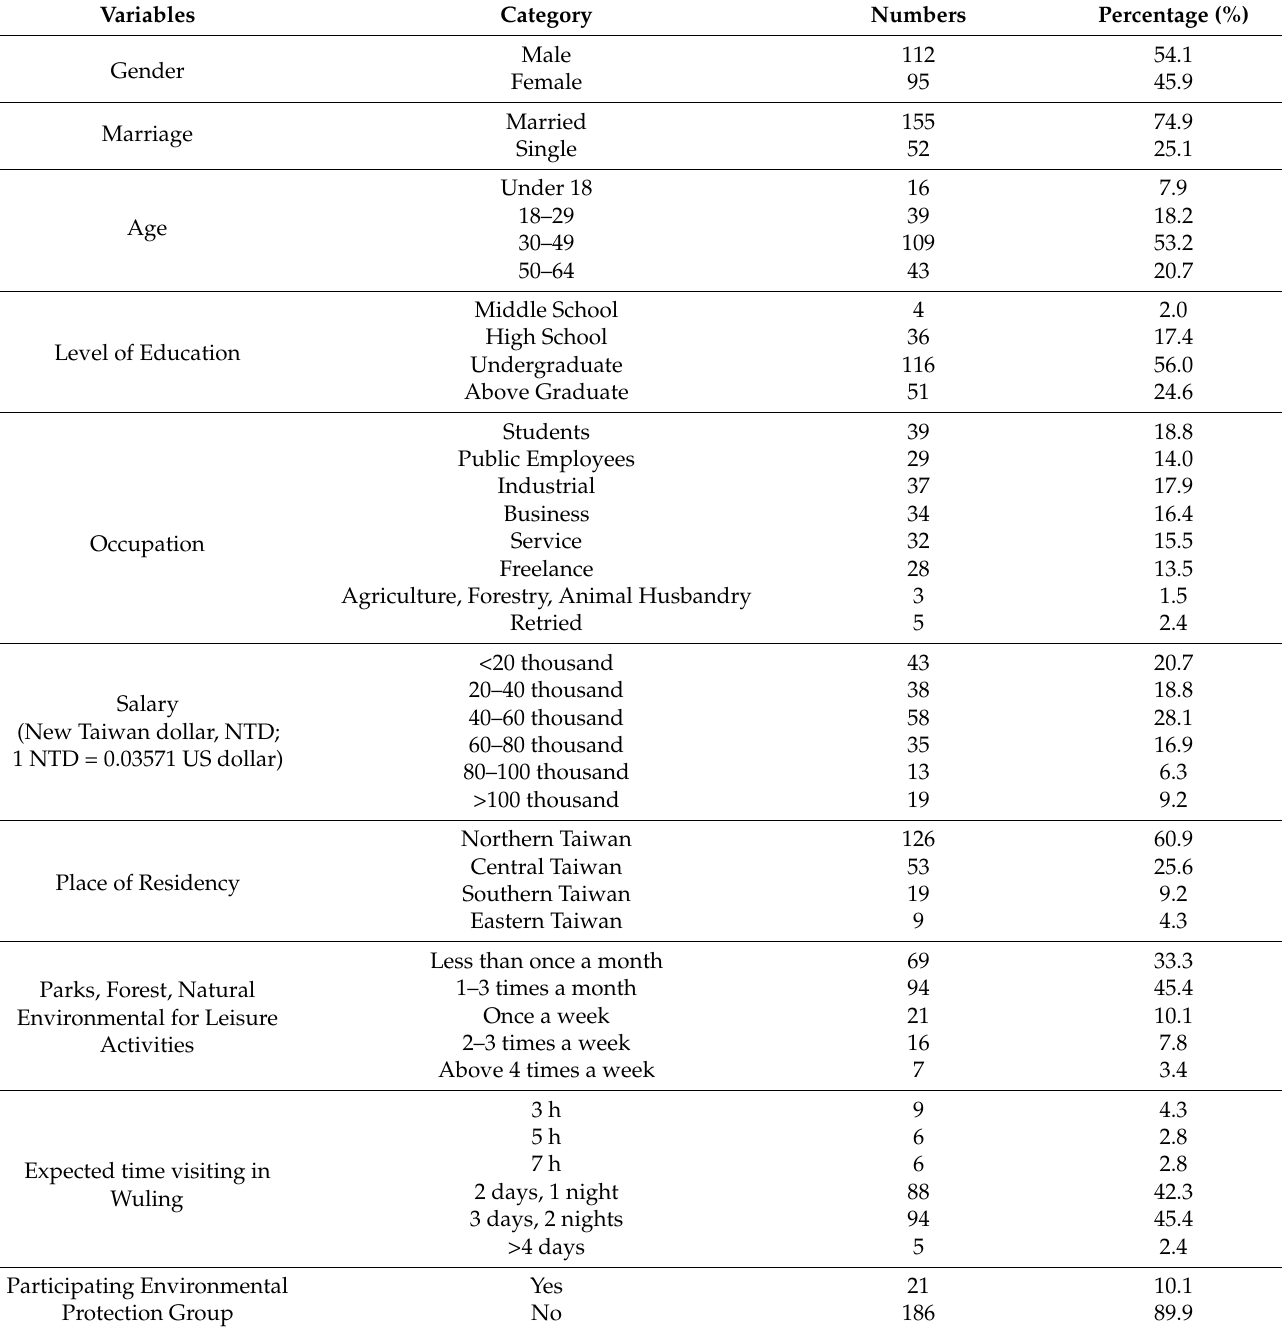
Table 2. Sociodemographic background of visitors and statistics of their recreational